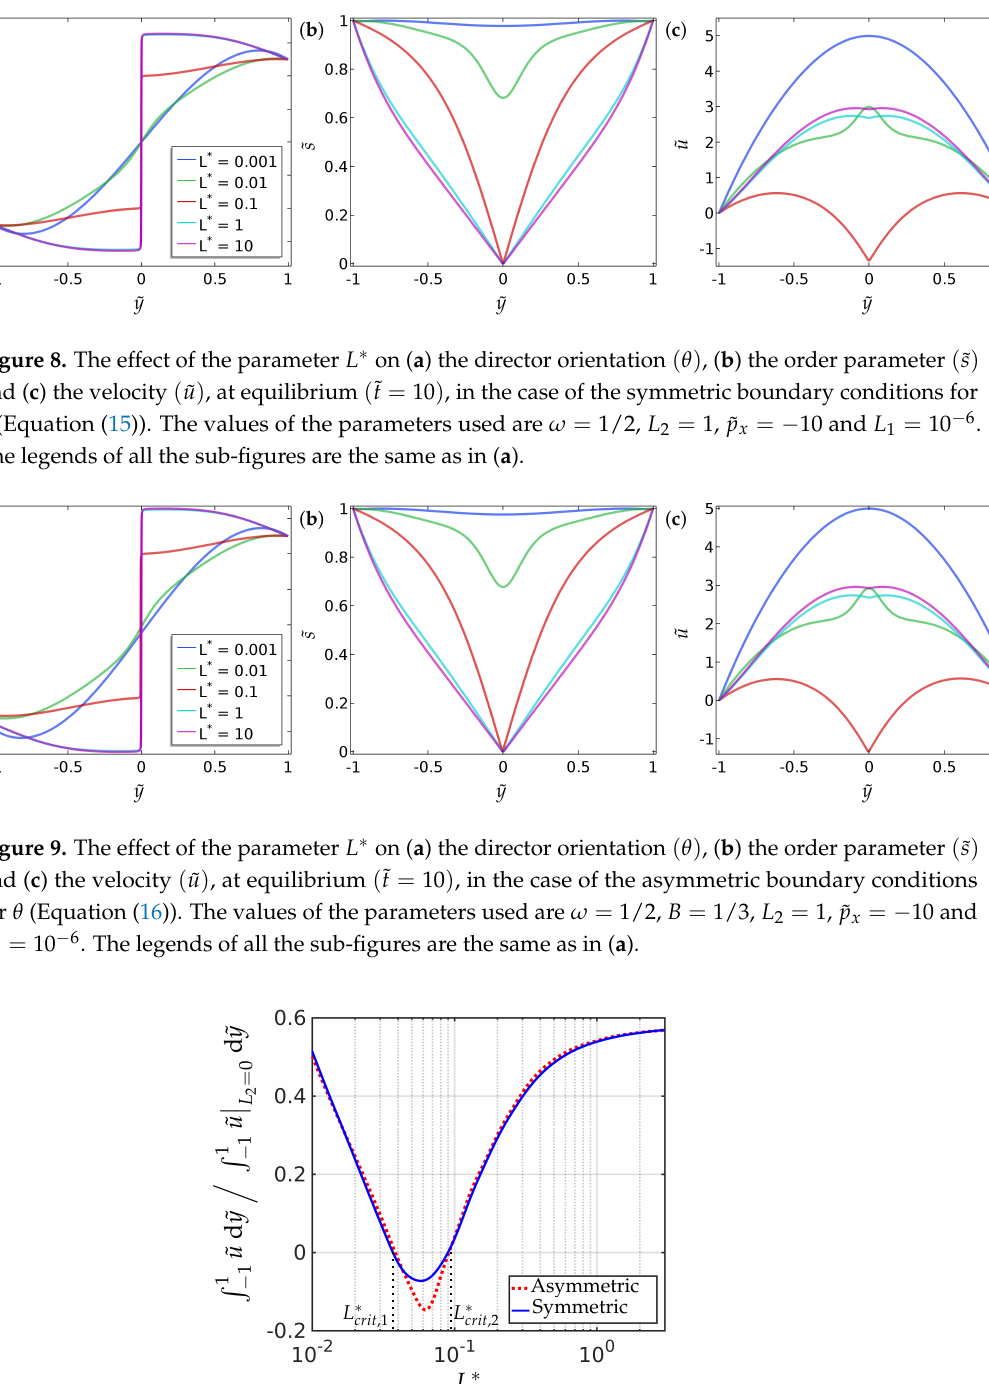
Figure 10. The effect of the parameter L ∗ on the net fluid flow rate at equilibrium ( ˜ t = 10 ) , for the asymmetric (Equation (16)) and symmetric case (Equation (15)). The values of the parameters used are B = 1/3, ω = 1/2, L 2 = 1, ˜ p x = 10 and L 1 = 10 − 6 . The total flow rate is scaled with the equivalent − (cid:82) 1 ˜ u Poiseuille flow rate, d ˜ y = 2 ˜ p x 1 | L 2 , L 1 = 0 − −